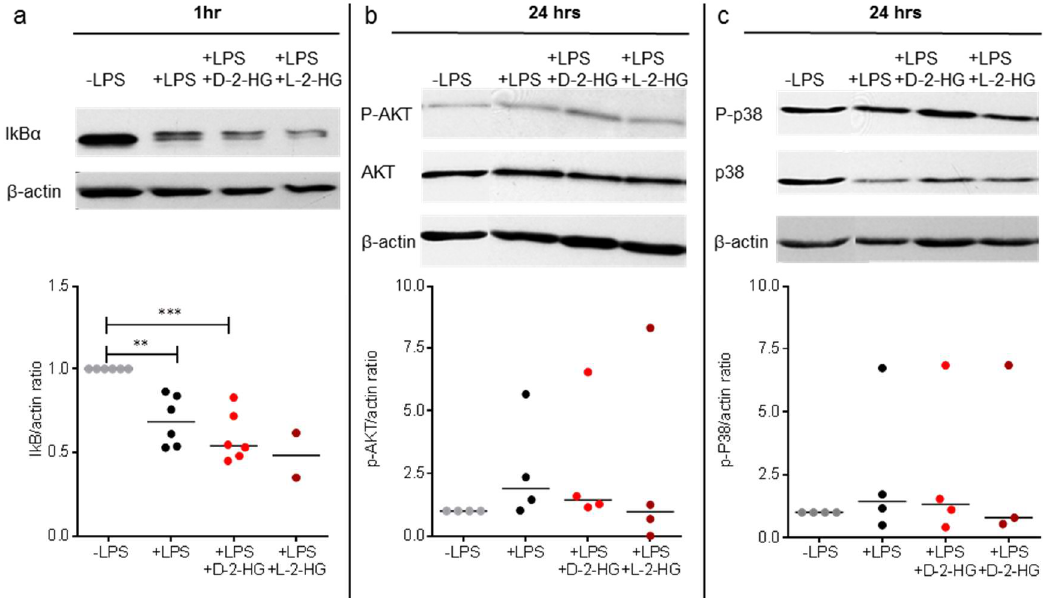
Figure 4. 2-HG has no impact on LPS-associated signaling. DCs were stimulated with LPS (100 ng/mL) and treated with or without 10 mM 2-HG. After 1 h (IκB) or 24 h (P-Akt, P-p38) of treatment, cell pellets were lysed and analyzed by western blot. ( a ) IκB expression was analyzed in DCs treated with LPS alone or in combination with 2-HG. Data represent the median of six independent experiments. Statistical analysis was tested with the Kruskal-Wallis Test (* p ≤ 0.01, *** p ≤ 0.001). ( b , c ) P-Akt and P-p38 protein expression in DCs treated with LPS alone or in combination with 2-HG were analyzed. Data represent the median of four independent experiments. Statistical analysis was performed using the Kruskal-Wallis